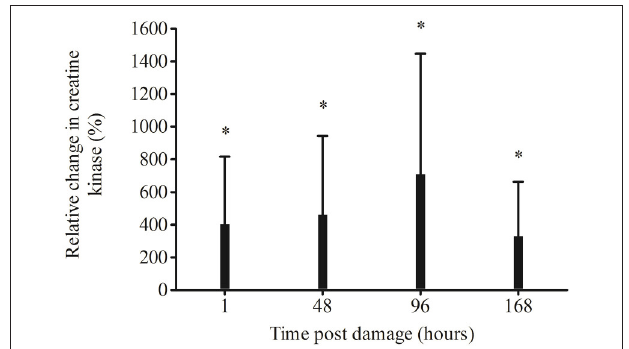
FIGURE 2 | Relative change in creatine kinase from pre-damage ( − 48 h), following exercise-induced muscle damage. *Significantly higher than pre-damage p < 0.01.